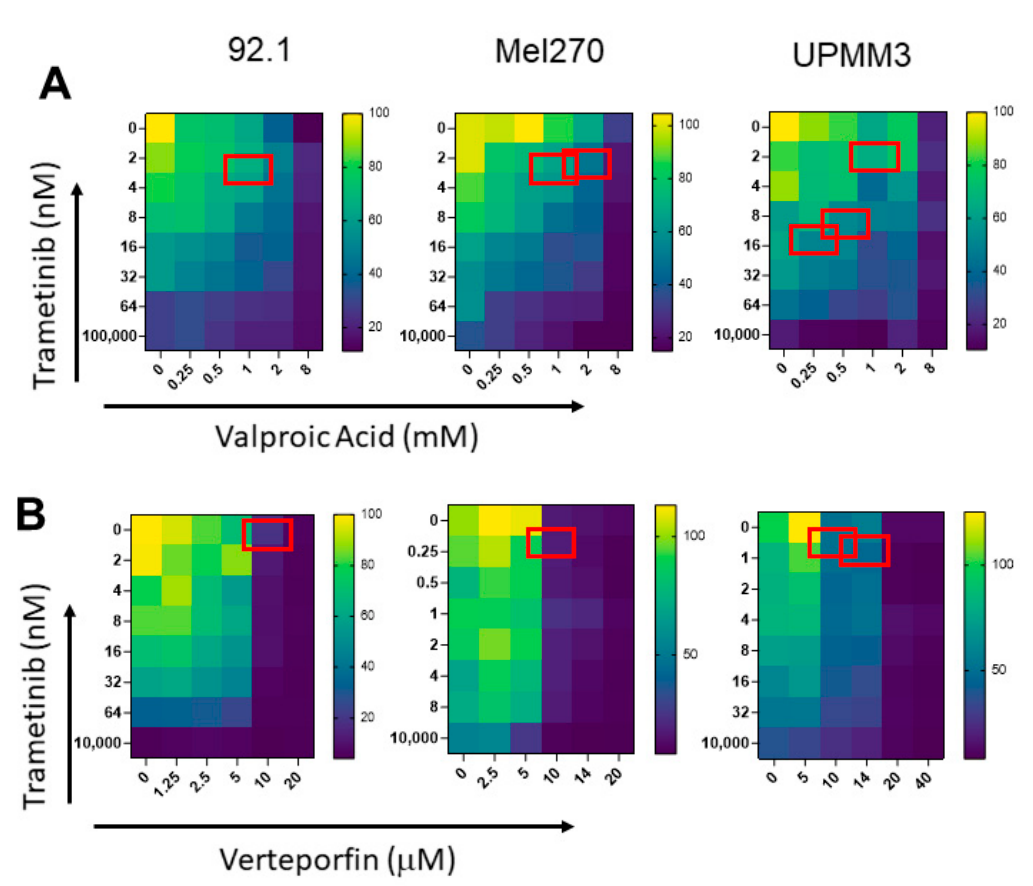
Figure 2. Minimal dose–response matrices showing trametinib-based combinations with VPA ( A ) and verteporfin ( B ) by MTT assay, at 72 h. Synergistic combinations, as calculated using the Chou–Talalay method, are indicated by red boxes. Cell viability is reported by a colour code ranging from yellow (100%) to dark blue (<20%) as indicated by the bar on the